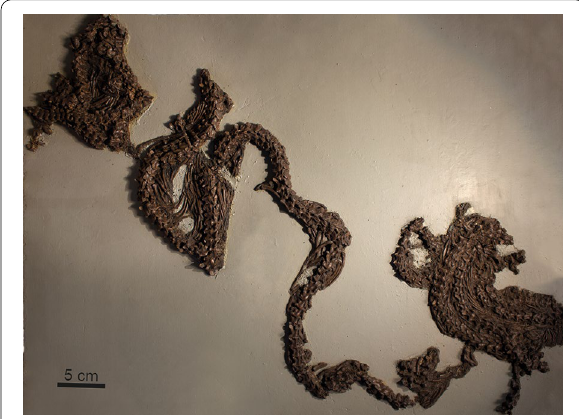
Fig. 24 Palaeopython ceciliensis from quarry XXXVI, Geiseltal: several articulated vertebrae on matrix (GMH XXXVI-41-1962)